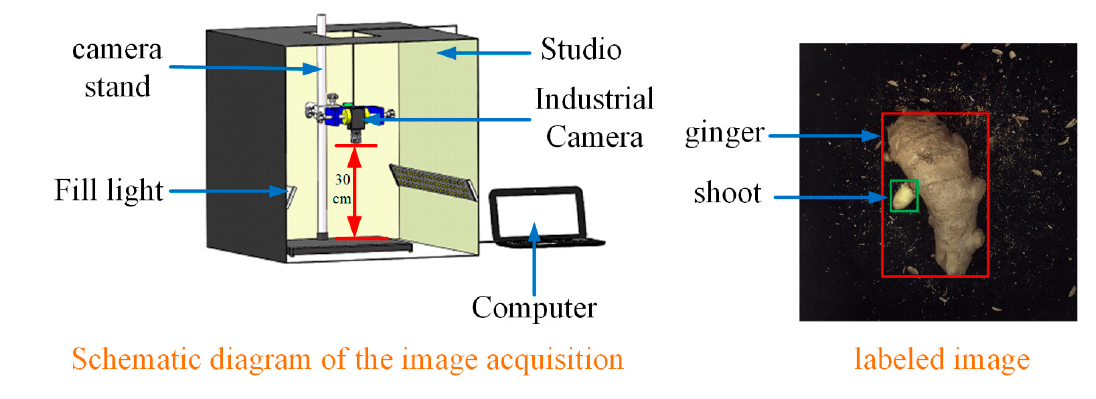
Figure 1. Schematic diagram of image acquisition and annotation. As shown in Figure 1, LabelImg (https://github.com/tzutalin/labelImg, accessed on 9 August 2021) was used to label the ginger shoots and ginger separately in “xml” file format, to determine the orientation of the ginger shoots; and it is worth noting that the labeled boxes are tightly aligned with the edges of the ginger and ginger shoots. In addition, the annotation information of each image was stored in a “txt” file, including image path, annotation box coordinates (image coordinates of the upper left and lower right corners), and object category. After image annotation, 1000 images were randomly divided into training and validation sets in the ratio of 80% and 20%, and the remaining 100